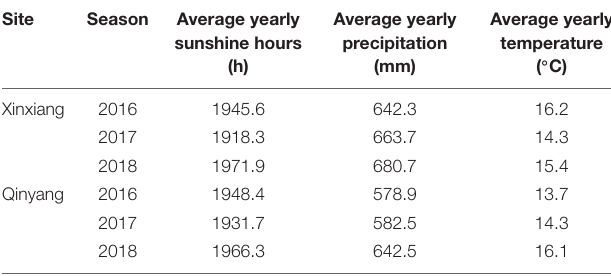
TABLE 2 | The weather condition from 2016 to 2018.